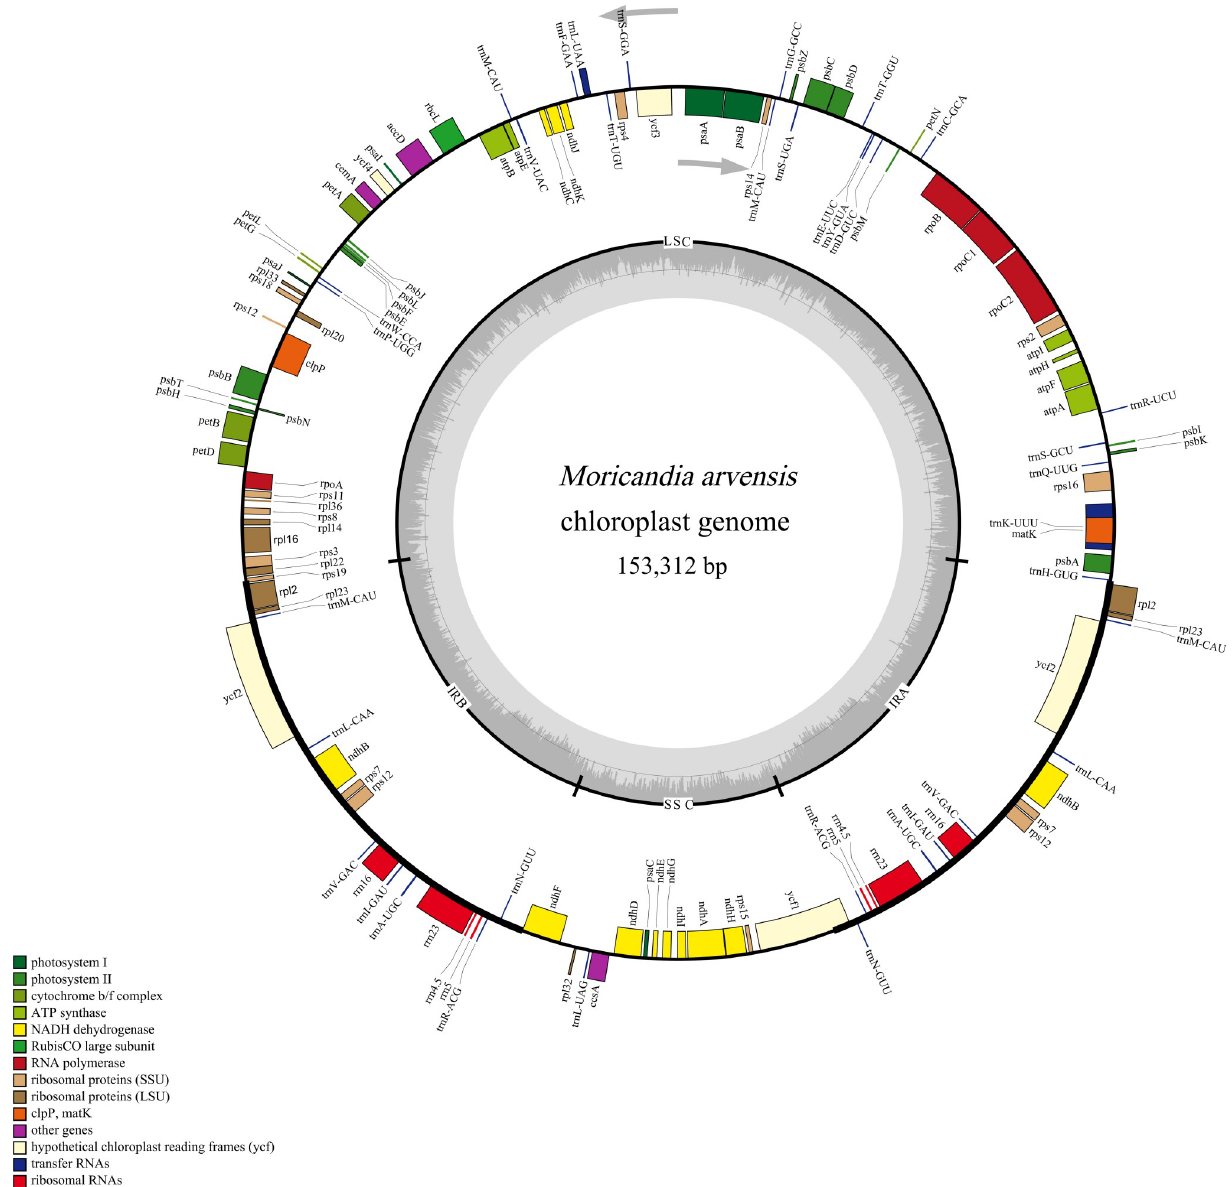
Fig 1. Gene map of the complete M . arvensis cp genome. Genes on the outside and inside of the circle are transcribed in clockwise and counterclockwise directions, respectively. Genes belonging to different functional groups are color coded. Color intensity refering to the inner circle corresponds to GC content. The SSC, LSC, and inverted repeat regions (IRA and IRB) are